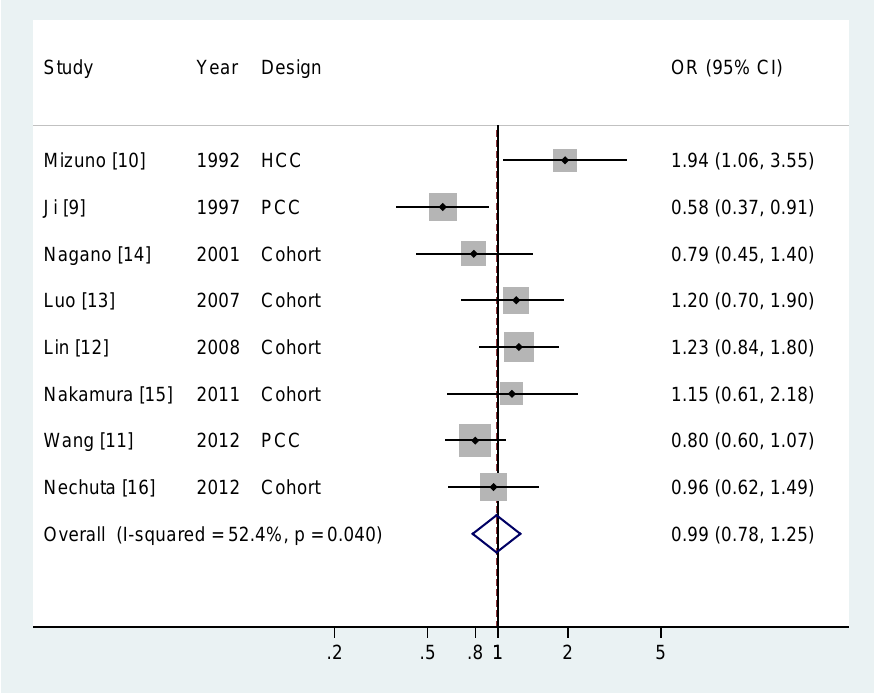
Figure 2 . The odds ratio of pancreatic cancer for the highest versus lowest categories of green tea consumption for each study and all studies combined [9–16].